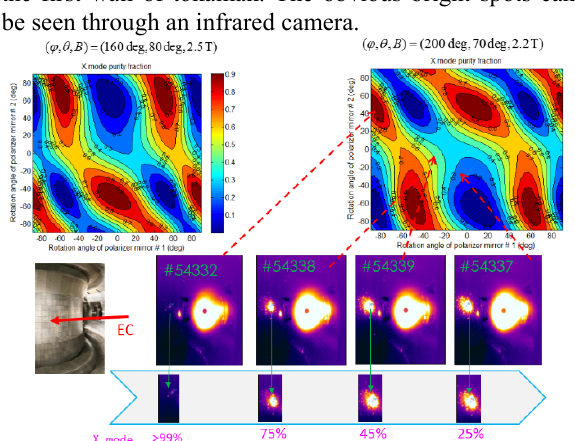
Fig. 10. Influence of different polarization on plasma absorption efficiency.